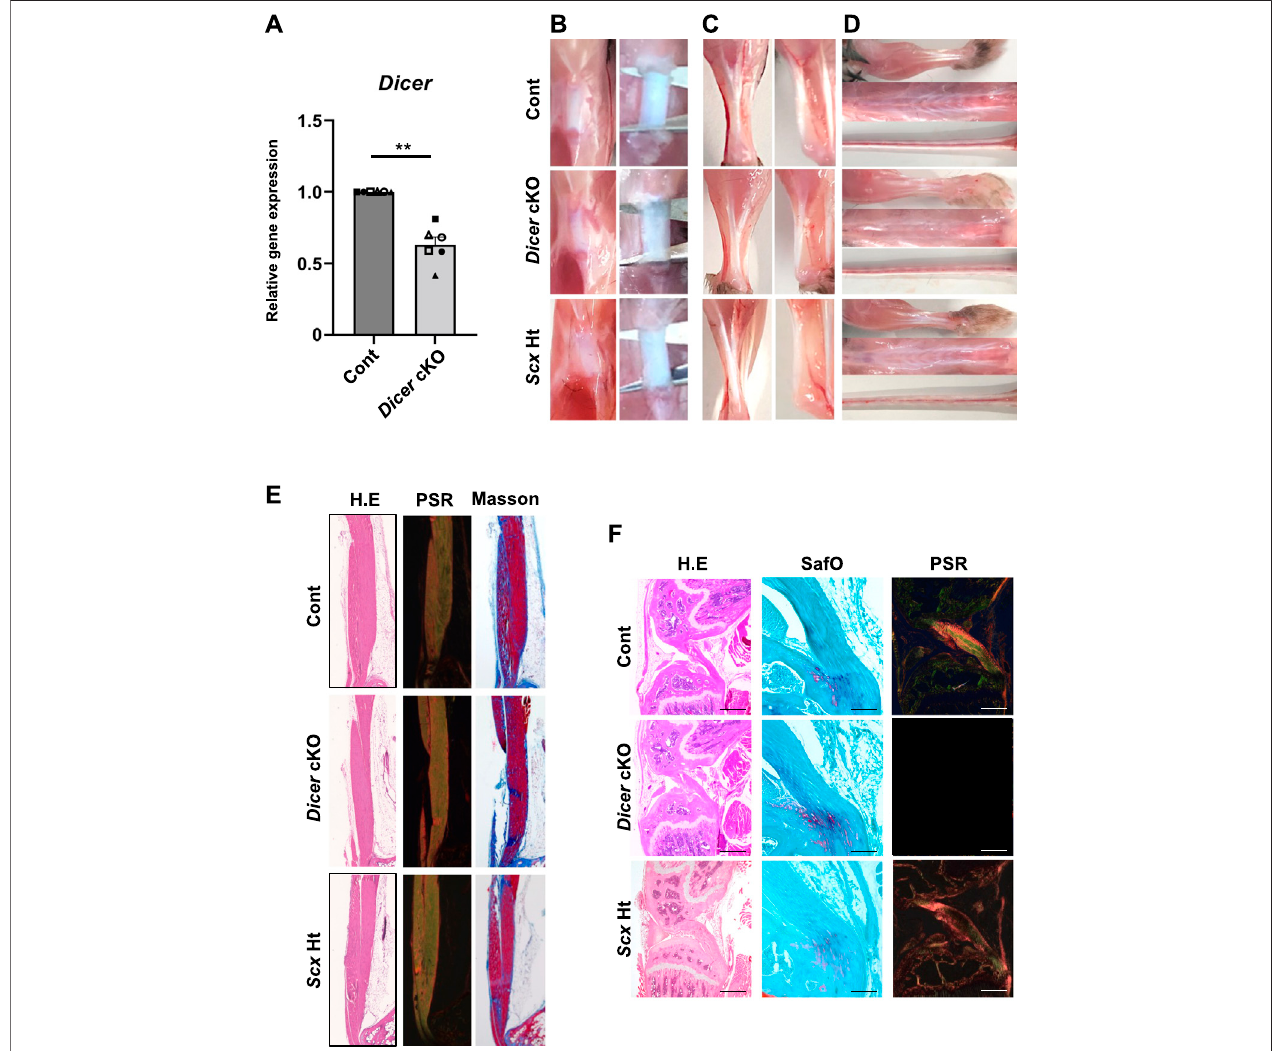
FIGURE 1 | Macroscopic and histological fi nding in Tendons of Dicer cKO mice. (A) The expression of Dicer in Achilles tendon of Cont and Dicer cKO mice ( n = 6 mice for each genotype) at 4 weeks of age was shown by real-time PCR. Data are represented as mean ± SEM. Comparison of Dicer expression was performed using Mann-Whitney Utest; ** p < 0.01. (B) Macro viewofPatellartendon, (C) Achillestendon, (D) forelimb tendons,back tendon andtail tendons in Dicer f/f (Cont), Scx Cre/+ KI: Dicer fl ox/ fl ox ( Dicer cKO), and Scx Cre/+ KI: Dicer +/+ ( Scx Ht) mice at 10 weeks of age. (E) Hematoxylin and Eosin (H.E), Picsirius red and Masson trichrome staining of AchillestendonofCont, Dicer cKO,and Scx Htmiceat10 weeksofage. (F) H.E,safraninO/FastgreenandPicsiriusredstainingofcruciateligamentofCont, Dicer cKO, and Scx Ht mice at 10 weeks of age. Scale bars: 100 and 500 µm.